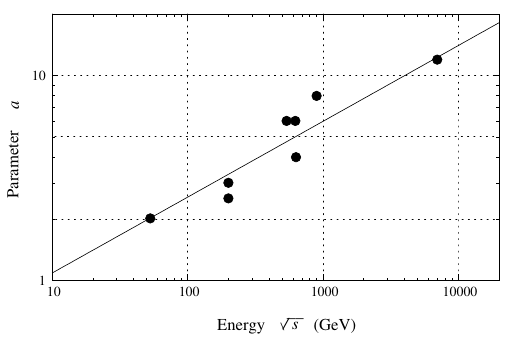
Figure 3. Energy dependence of the parameter a , tabulated in Table 1. The solid line is eq.(7) in the